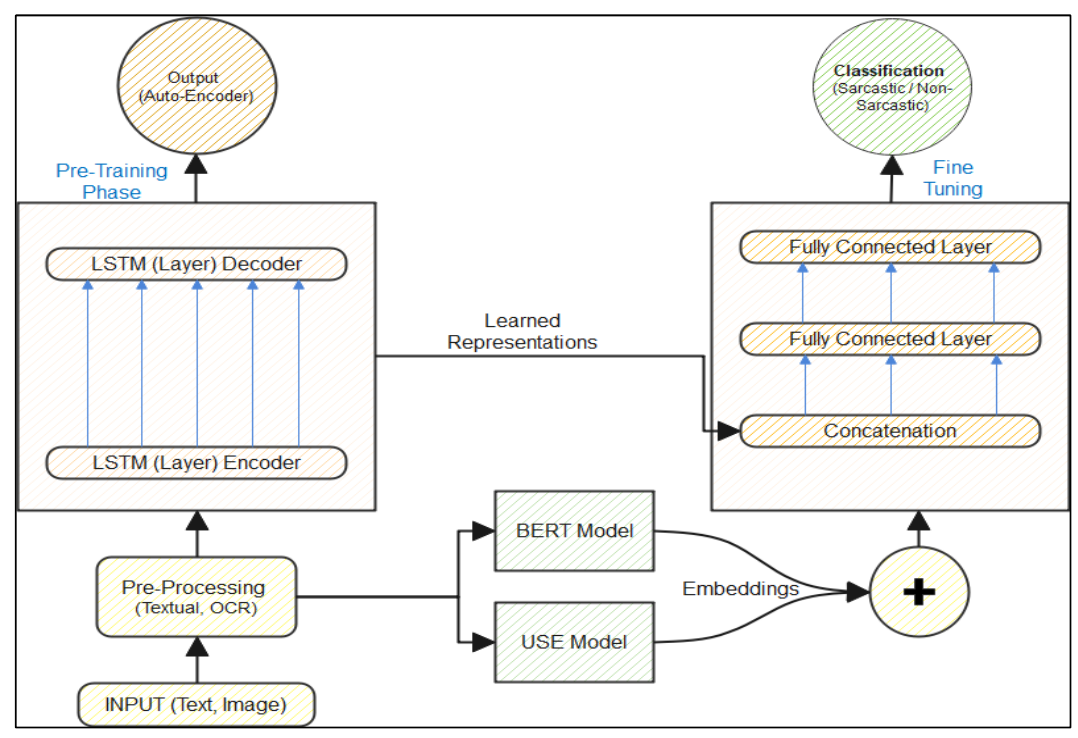
Figure 5. Architecture diagram of the proposed model.